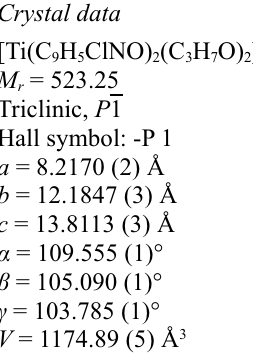
Figure 1 Anisotropic displacement ellipsoid plot (Barbour, 2001) of Ti(C 70% probability level and H atoms of arbitrary radius. Only the major occupied site of the disordered atom is shown. Bis(5-chloroquinolin-8-olato- κ 2 N , O )bis(propan-2-olato- κ O )titanium(IV) Crystal